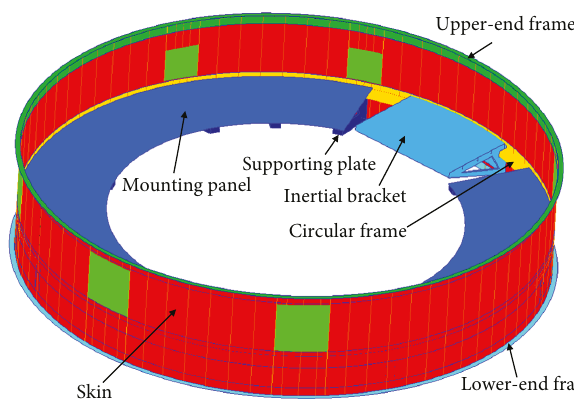
Figure 1: Geometry of the equipment bay.